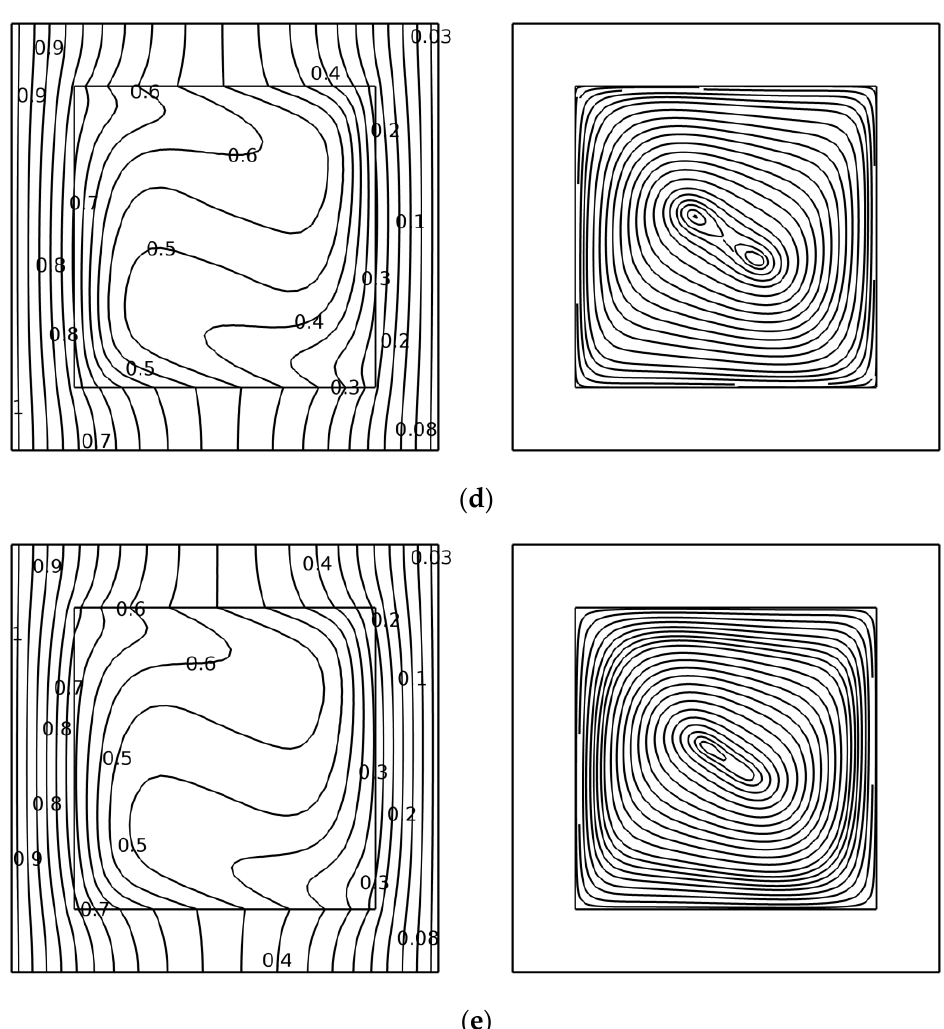
Figure 7. Streamlines and isothermals obtained for ( a ) ε = 0.2, W max = 76.364, ( b ) ε = 0.4, W max = 71.407, ( c ) ε = 0.6, W max = 66.759, ( d ) ε = 0.8, W max = 62.328 and ( e ) ε = 1, W max = 58.528.